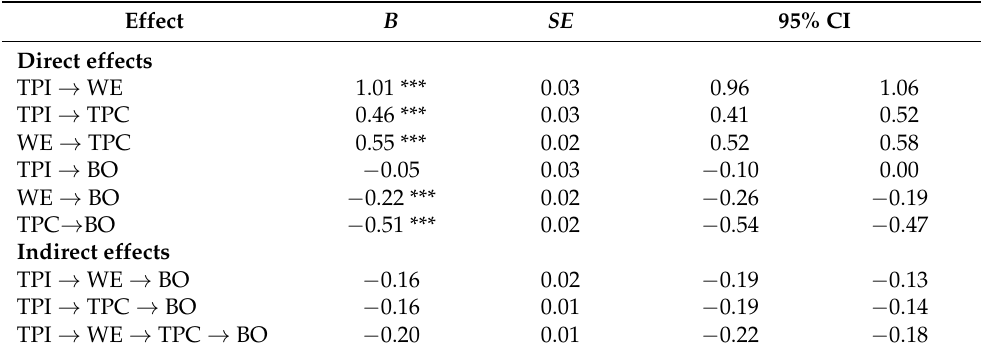
Table 4. Testing the pathways of the multiple mediation model.